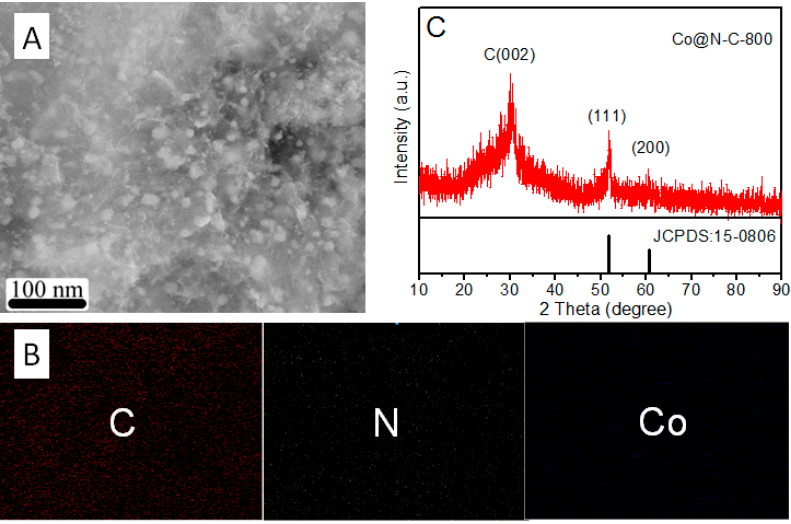
Figure 1. ( A ) scanning electron microscope (SEM) images of Co@N-C-800, ( B ) the element mapping of Co@N-C-800 corresponding to image a, ( C ) X-ray diffractometer (XRD) pattern of Co@N-C-800.